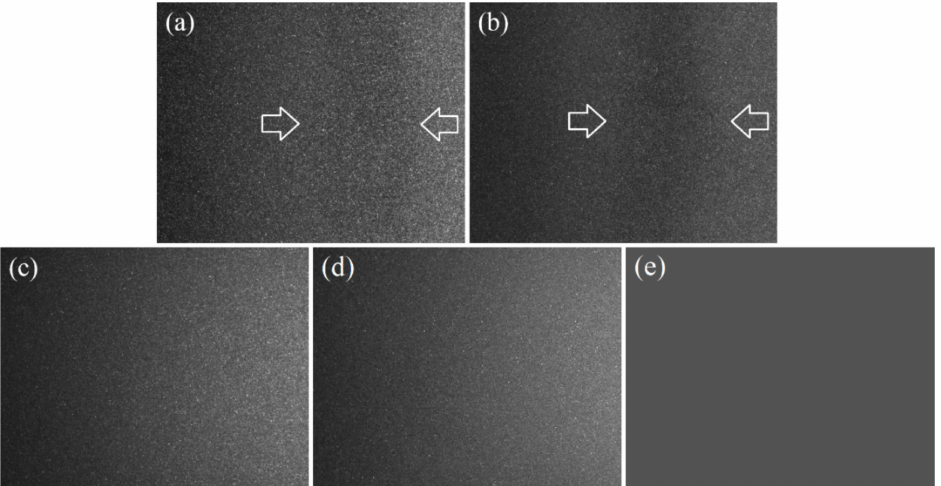
Figure 10. Images of ( a ) the grey and ( b ) the blue samples with stripes, and ( c ) the grey metallic, ( d ) the grey pearlescent and ( e ) the grey solid samples without striping for the white LED cluster at the geometry of 15 ◦ x: 0 ◦ . The arrows indicate the stripes in samples with